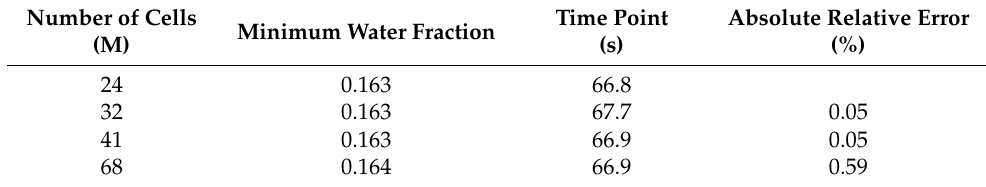
Table 2. Mesh independent analysis of the horizontal